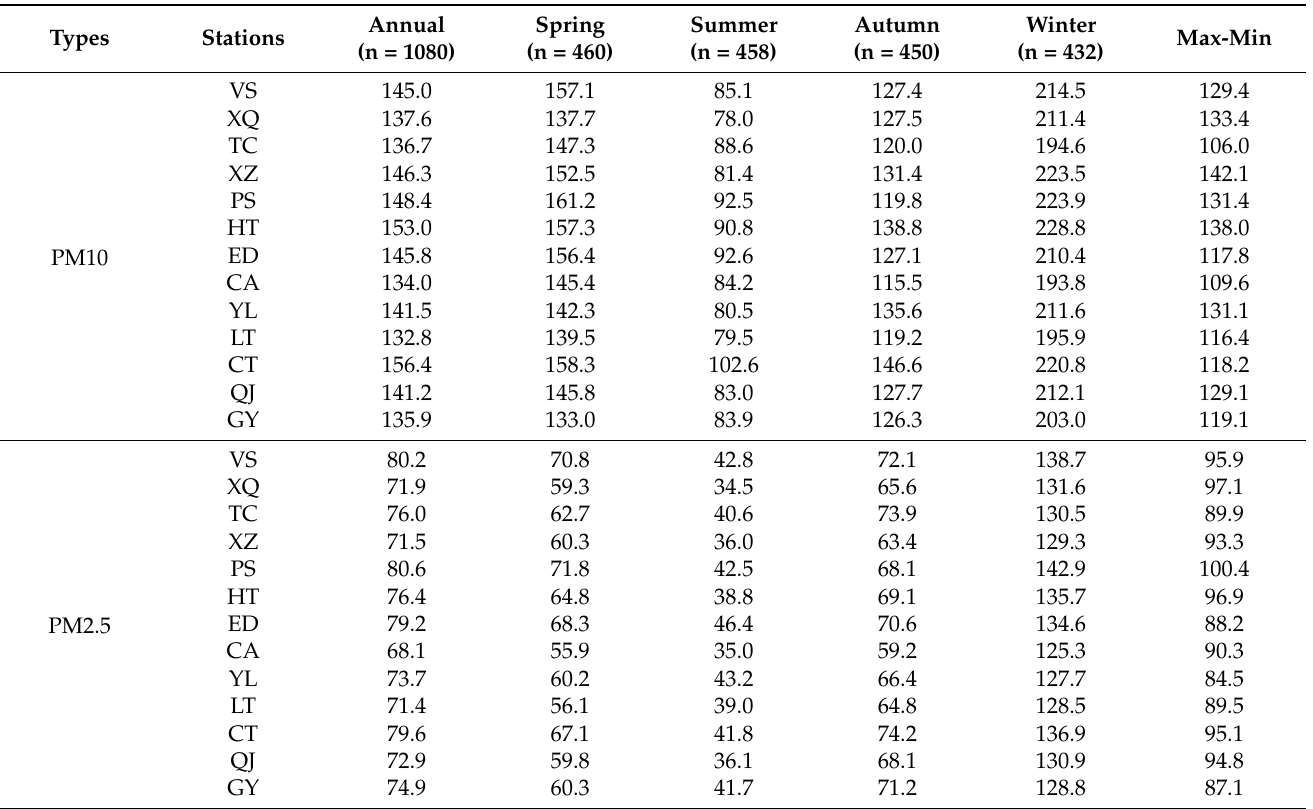
Table 2. The concentrations of PM10 and PM2.5 among monitoring stations in Xi’an annually and seasonally.